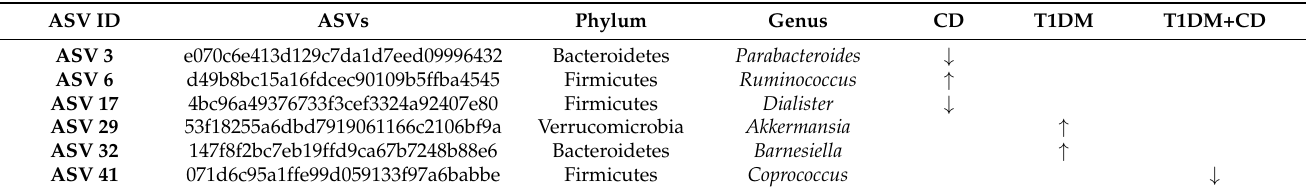
Table 2. Differentially abundant ASVs exclusive to each of the diseased groups (CD, T1DM, T1DM+CD) compared to healthy controls. ↑ (increased abundance relative to healthy control) ↓ (decreased abundance relative to healthy control) Abbreviations: T1DM = Type 1 Diabetes; CD = Coeliac disease; ASV = Amplicon sequence variant.